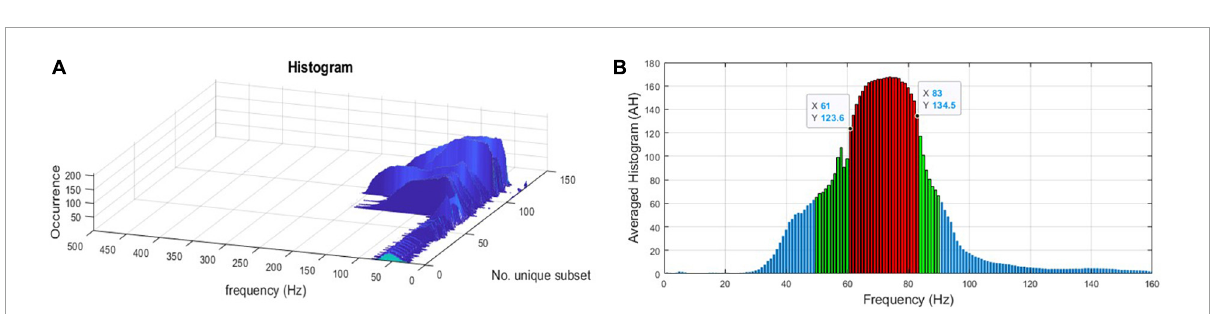
FIGURE3 (A) A histogram of the intersected focal frequency band (FFB) per subset. (B) FFB after averaging histograms (AH) and applying the K -medoid clustering technique as the outliers’ statistics to pinpoint the range of the FFB for one of the “leave-out” 10th patients using the auto-spectra ( S kk ) measure of power. Red bars represent the selected FFB, and it is (61–83 Hz) for this “leave-out”